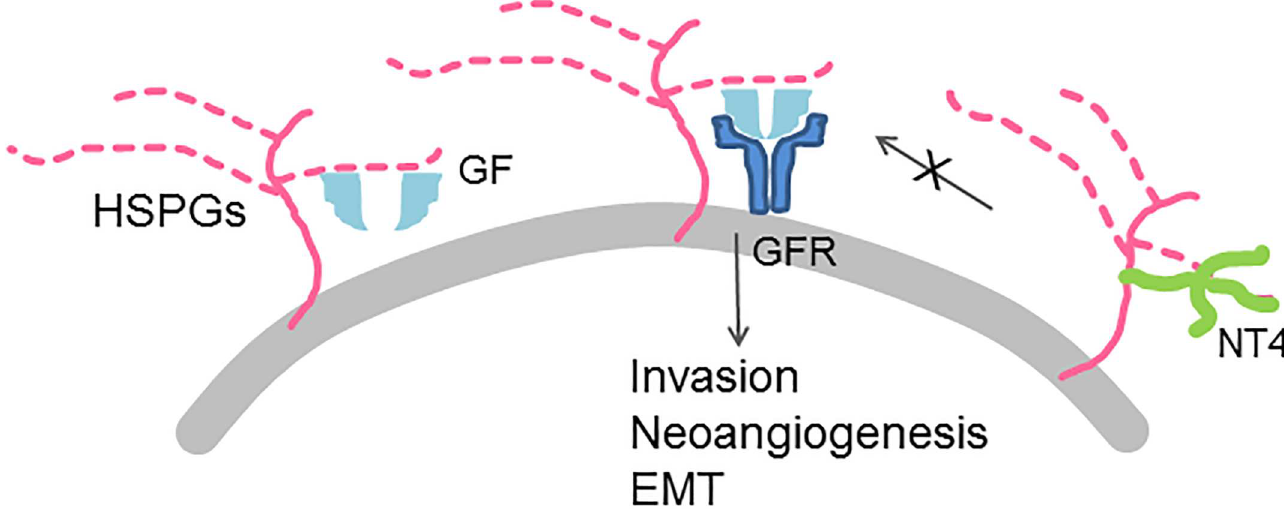
Fig 6. Scheme of the proposed mechanism of inhibition of invasion and neoangiogenesis by NT4.